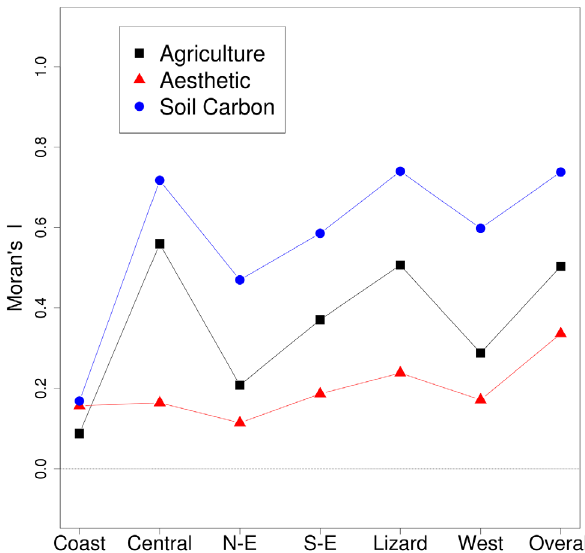
Figure 3. Test of spatial autocorrelation for agriculture, aesthetics and soil carbon data in Cornwall and within each geographical zone.